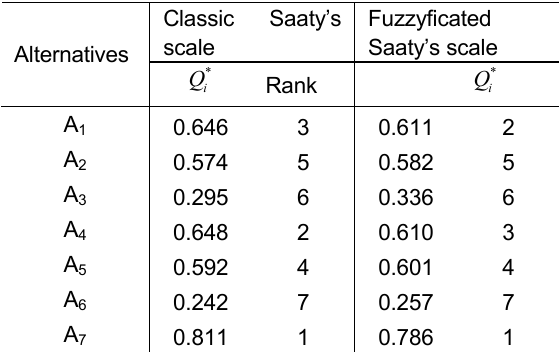
Table 4 – Comparative summary of the solutions with the change of the initial elements Таблица 4 – Сравнительный обзор решений с изменением исходных